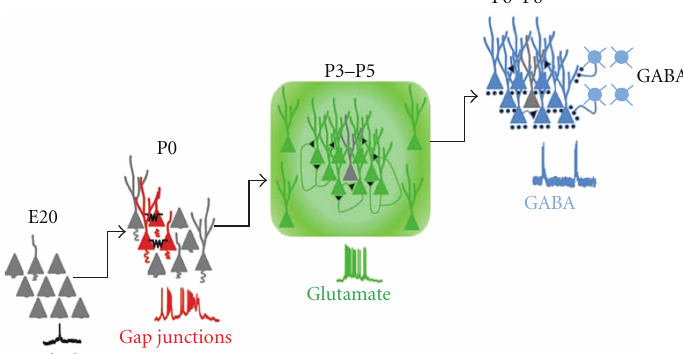
Figure 1: Patterns of electrical activity observed at late embryonic/early postnatal stages in the cortex. E20: uncorrelated calcium spikes; P0: Spontaneous Plateau Assemblies (SPAs) synchronized by gap junctions. P3–P5: early network oscillations (ENOs) mediated by glutamate. P6–P8: giant depolarizing potentials (GDPs) mediated by GABA and glutamate. (Modified from